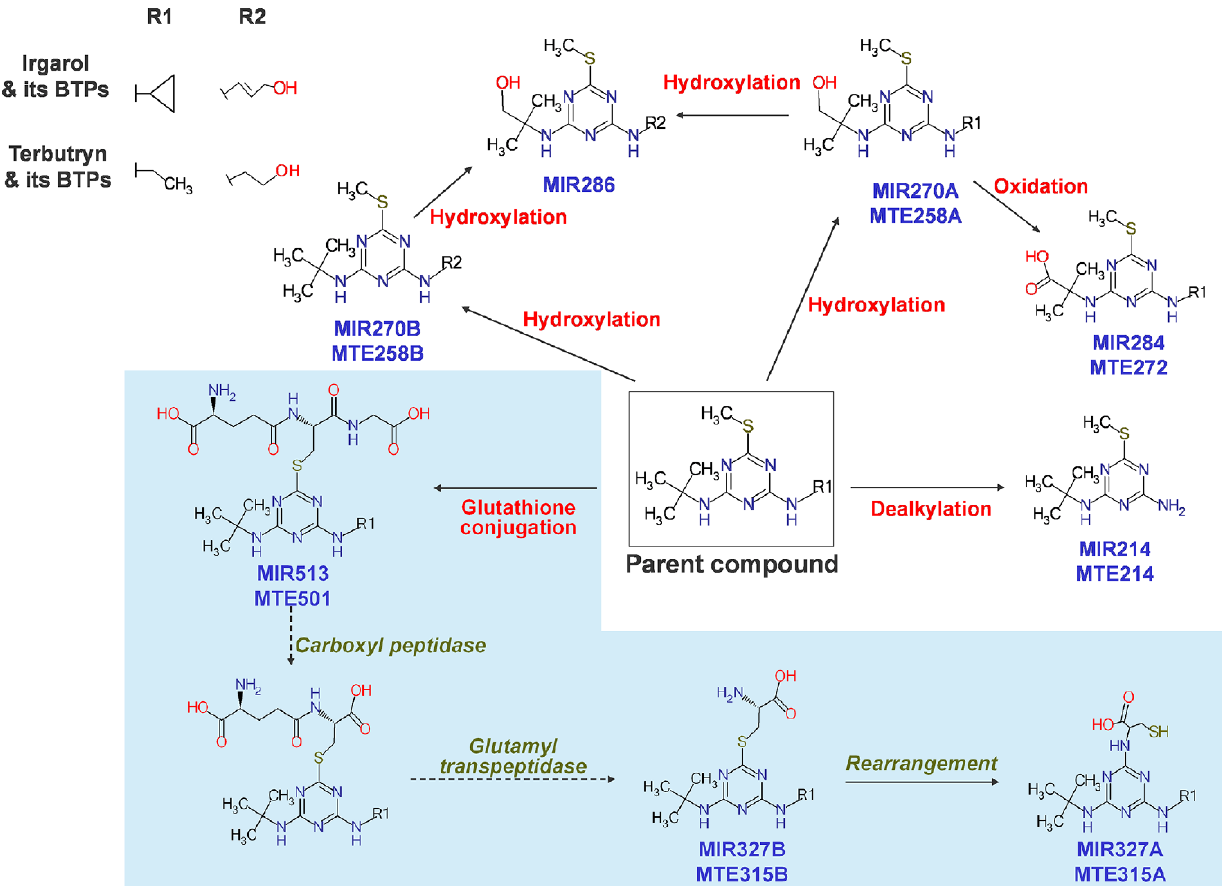
Figure 4. Proposed biotransformation pathways of irgarol and terbutryn in freshwater crustaceans. Note that R2 is the hydroxylated moiety of R1. The sky-blue shaded area indicates a pathway including glutathione conjugation followed by subsequent reactions to form cysteine conjugates, reported for the first time in the test organisms. (Reprinted from [118], Copy right 2021, ACS ).